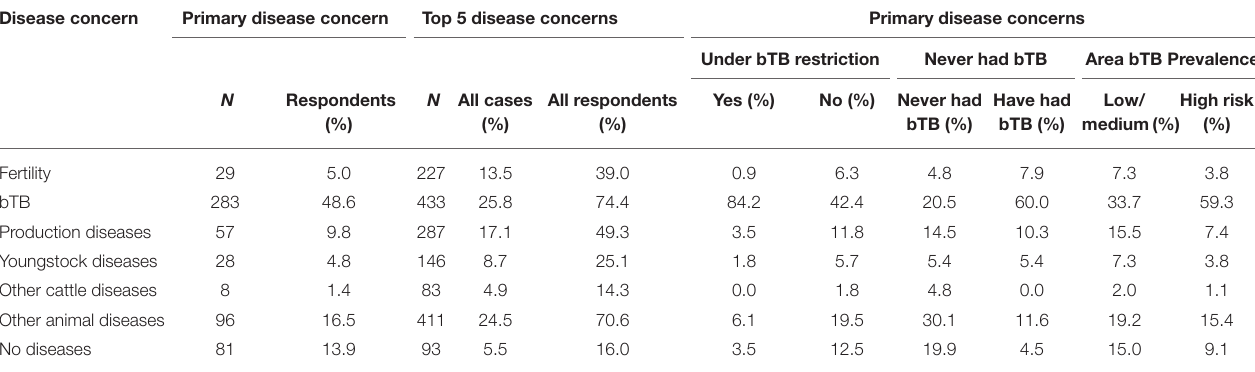
TABLE 3 | Diseases cited as most significant by surveyed farmers. Disease